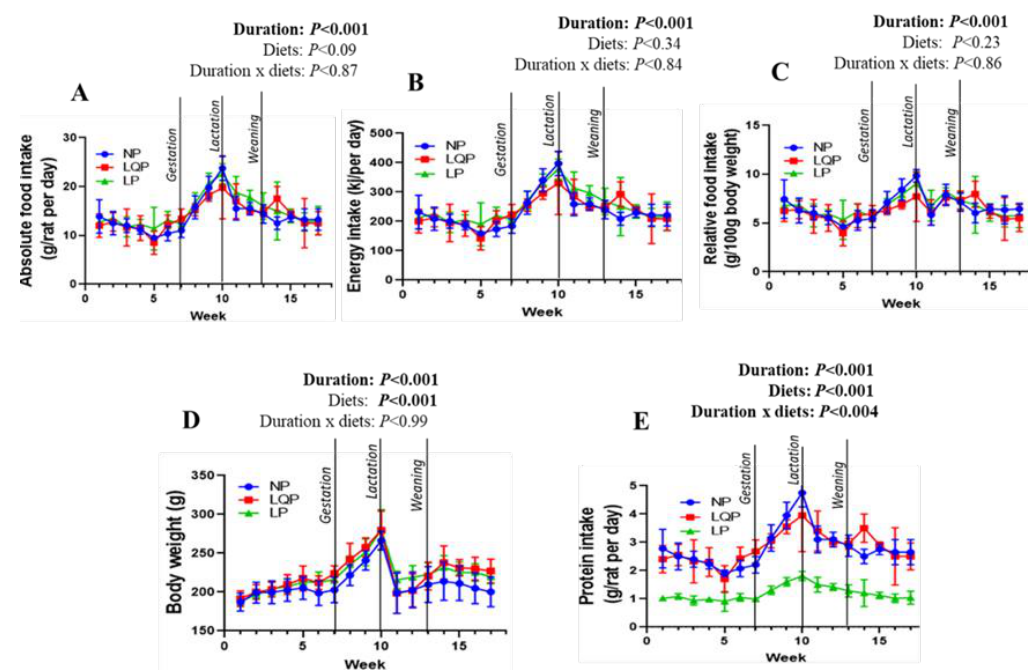
Figure 2. Effect of protein restriction on food intake and bodyweights (BWs) in mothers: the food intake was recorded daily, while BWs were recorded weekly. ( A ) Absolute food intake, ( B ) energy intake, ( C ) relative food intake, and ( D ) BWs ( E ) Protein intake. The data were tested using two-way ANOVA, and are represented as the mean ± SD ( n = 4 per group). NP, normal protein; LQP, low-quality protein; LP, low-protein.